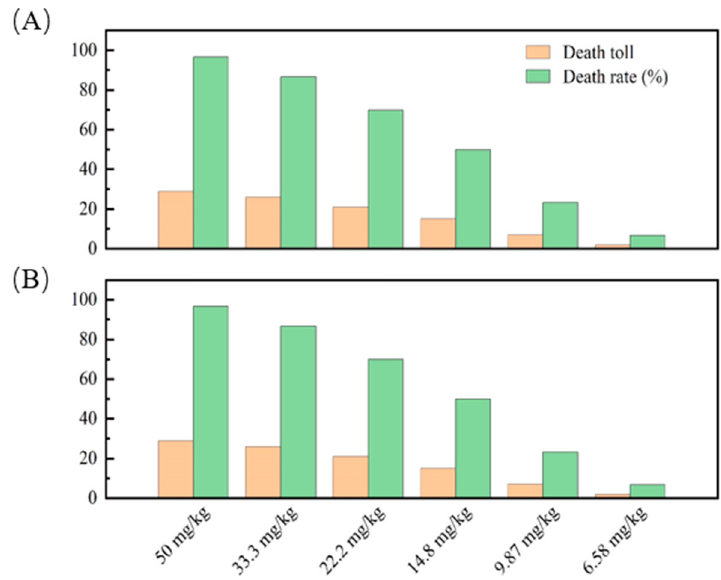
Figure 3. Earthworm mortality ( A ) 7 and ( B ) 14 days after treatment with six concentrations of TFC (mg/kg, dry soil): 6.58, 9.87, 14.8, 22.2, 33.3, and 50 mg/kg.